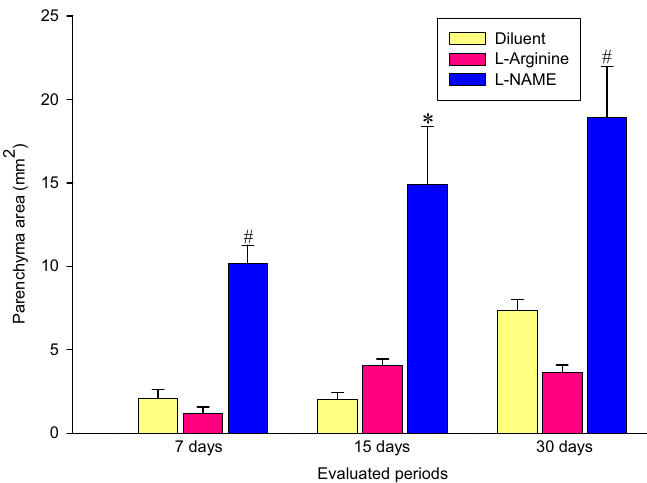
FIGURE 2 - Influence of L-Arginine and L-NAME treatments on tumor parenchyma.